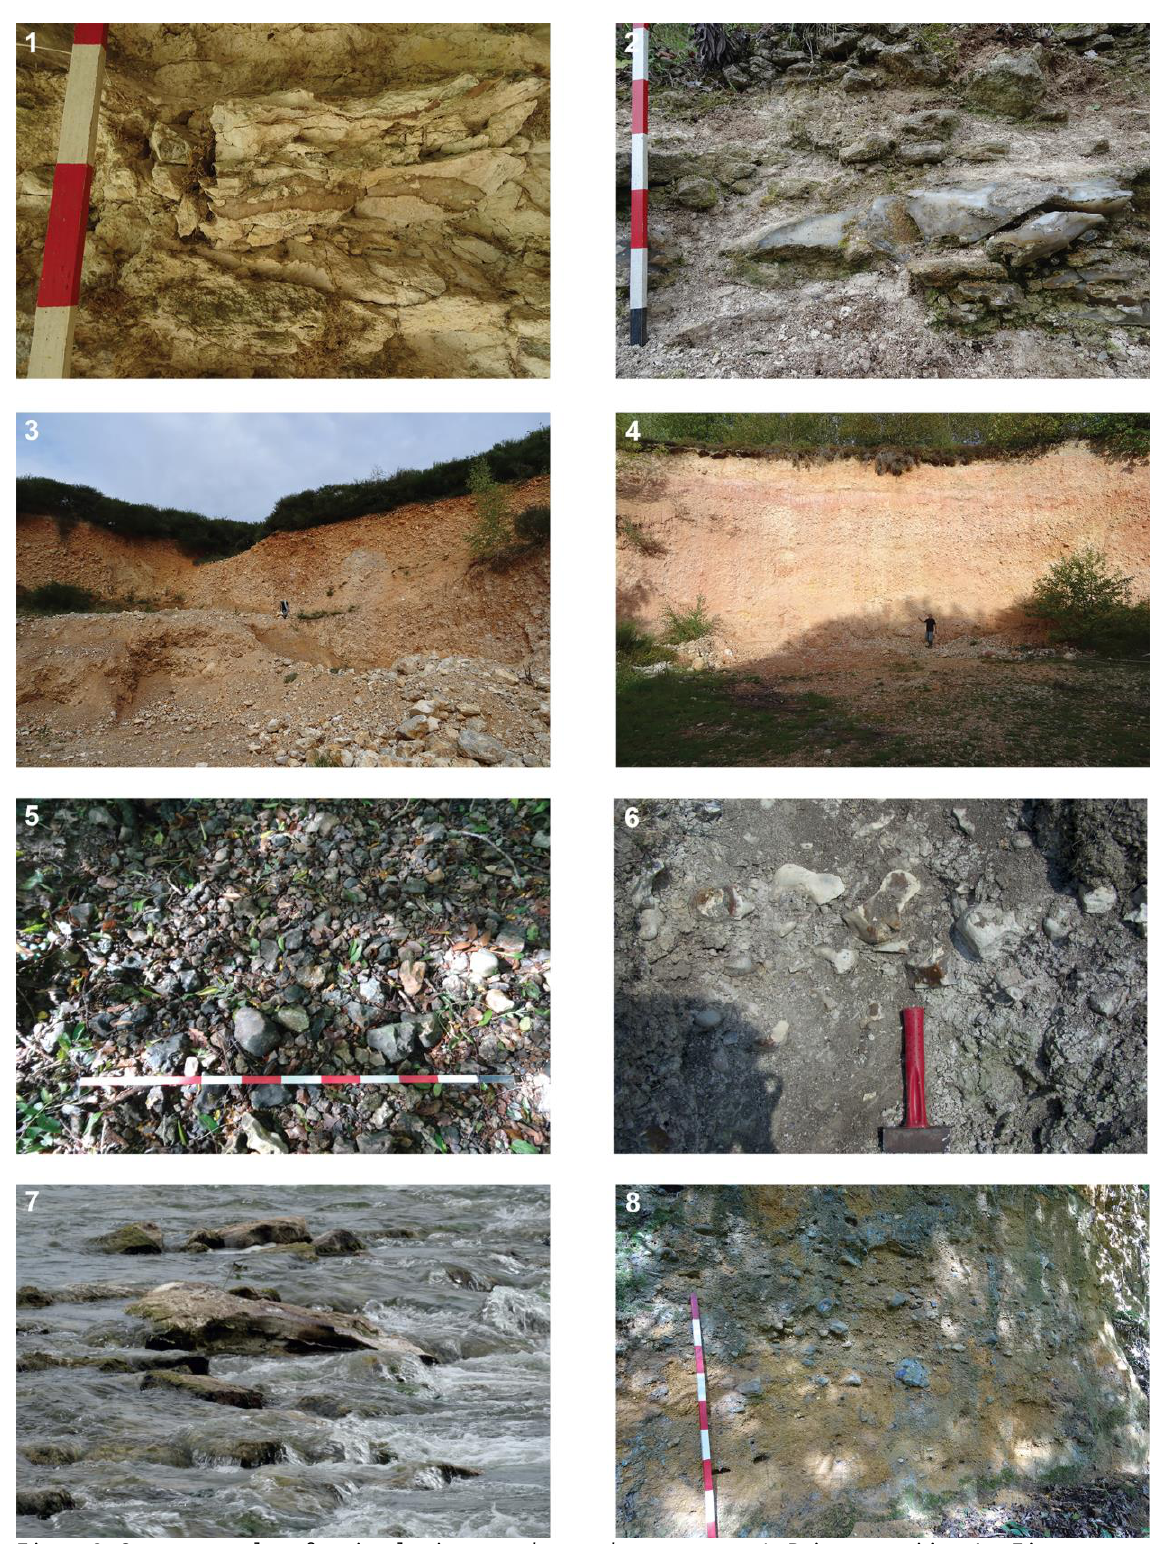
Figure 2. Some examples of regional primary and secondary outcrops. 1. Primary position: Le Firmament at Quincy (Cher); 2. Primary position: Les Fontaines Neuves at Chavannes (Cher); 3. Position of clay with flint: Le Fond des Bédus at Jars (Cher); 4. Position of clay with flint: La Riffauderie at Bannay (Cher); 5. Position of recent alluvials: Bellevue at Méry-es-Bois (Cher); 6. Colluvial position: La Musa at Meusnes (Loir-et-Cher); 7. Recent alluvial position: Le Clos Mailloux at Muides-sur-Loire (Loir-et-Cher); 8. Fossil alluvial position: Le Foulon at Beaulieu-sur-Loire